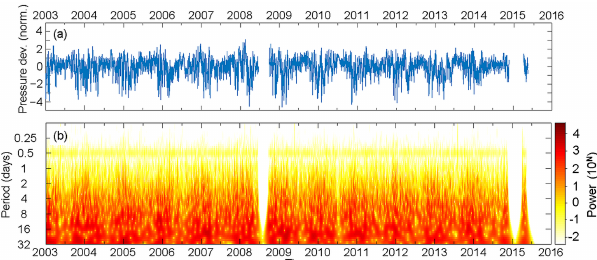
Figure 6. Wavelet analysis for station IS26 from 2003 to 2015. The time series in panel (a) corresponds to Fig. 4a but is normalized by its standard deviation, which amounts to 8.78hPa. The resulting power spectrum (b) is colour-coded. The ordinate axis represents the Fourier period in days.